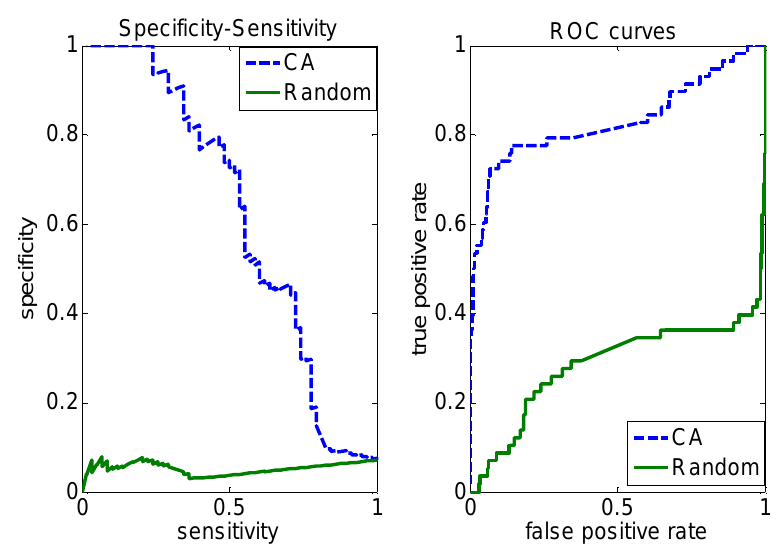
Figure 2. Specificity-sensitivity and ROC curves on the Trim